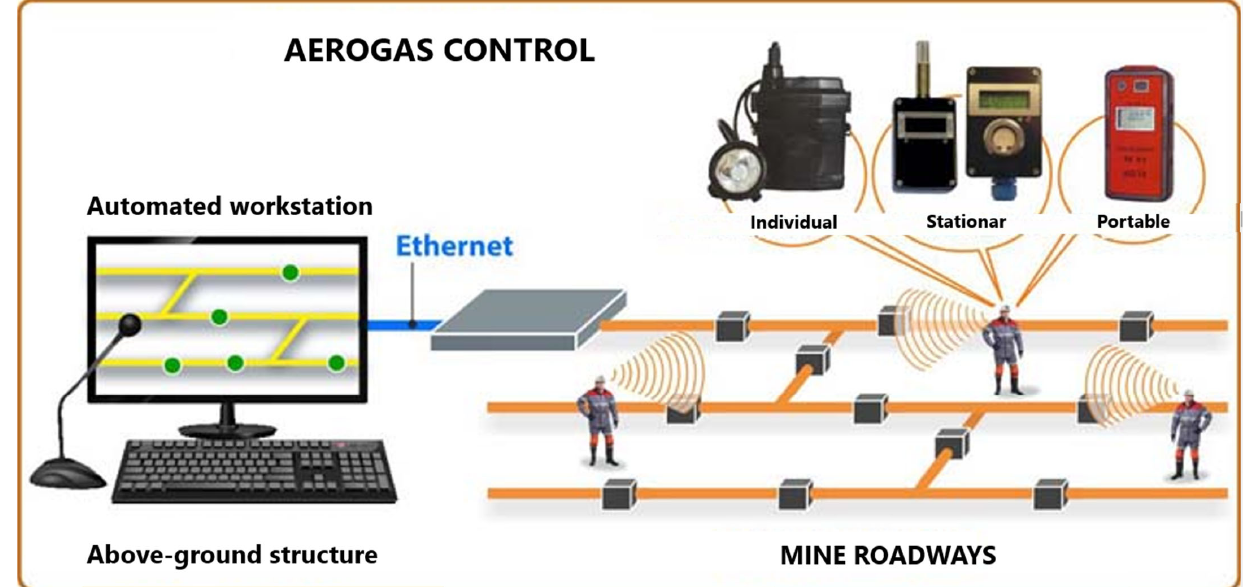
Figure 2. PACS for gas ‐ dynamic phenomena in mine monitoring. Based on the research results, a layout was developed to represent a visual model of the system for monitoring physical processes in coal deposits (Figure